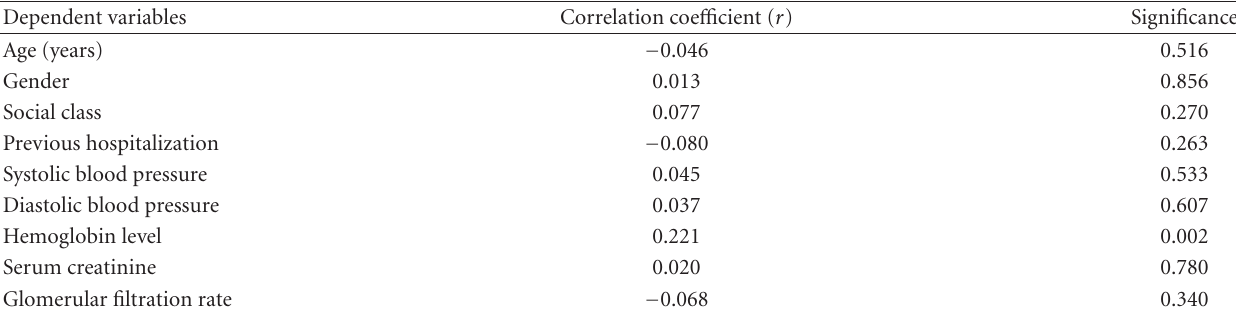
Table 3: Bivariate correlation analysis of the dependent variables of microalbuminuria among